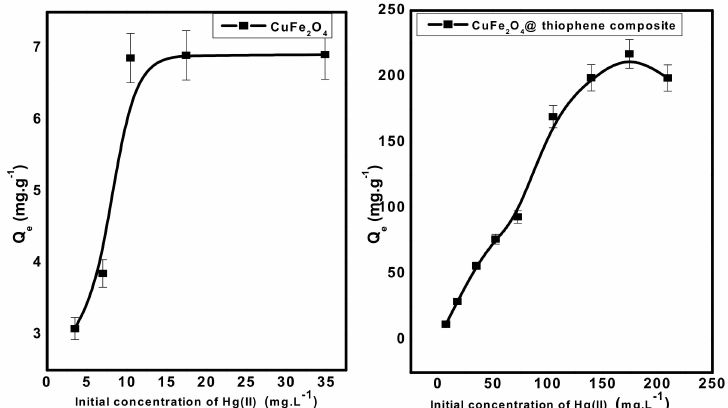
Figure 11. E ff ect of initial concentration of Hg(II) solution on removal of Hg(II) from aqueous solution. [Conditions: adsorbent dose = 0.03 g, pH = 6, volume of Hg(II) solution = 50 mL, contact time = 3 h and 30 min for CuFe 2 O 4 and CuFe 2 O 4 @Polythiophene composite; respectively).